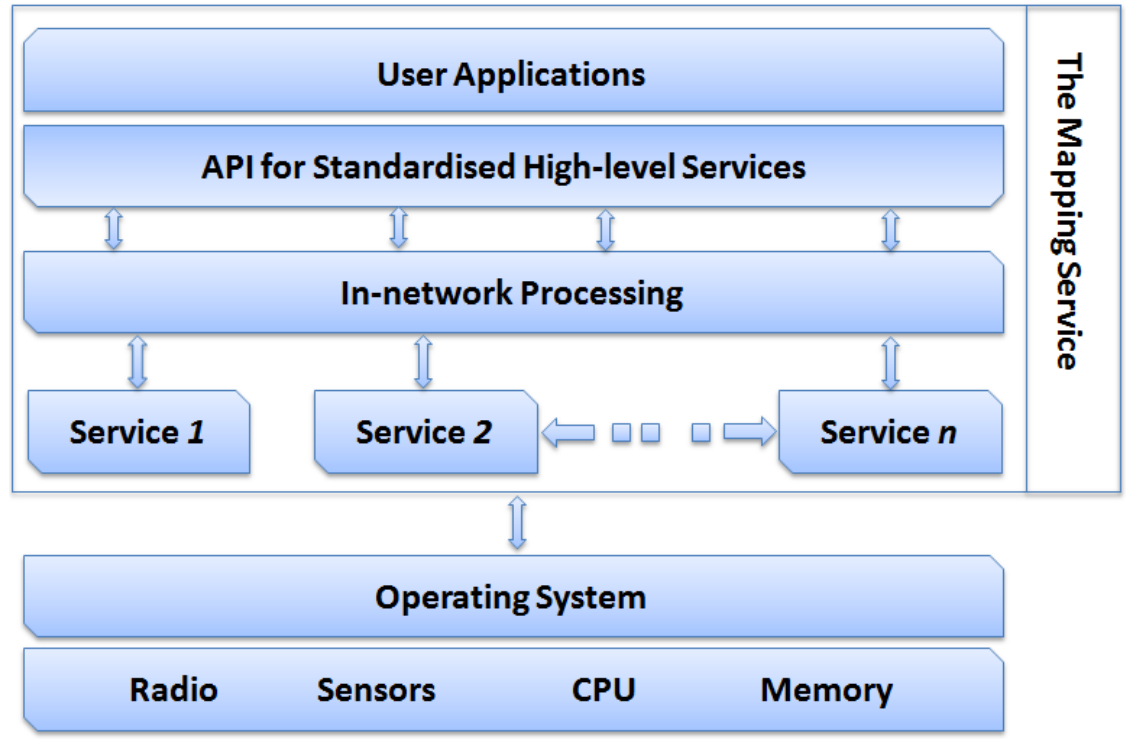
Figure 1. The architecture of the distributed mapping